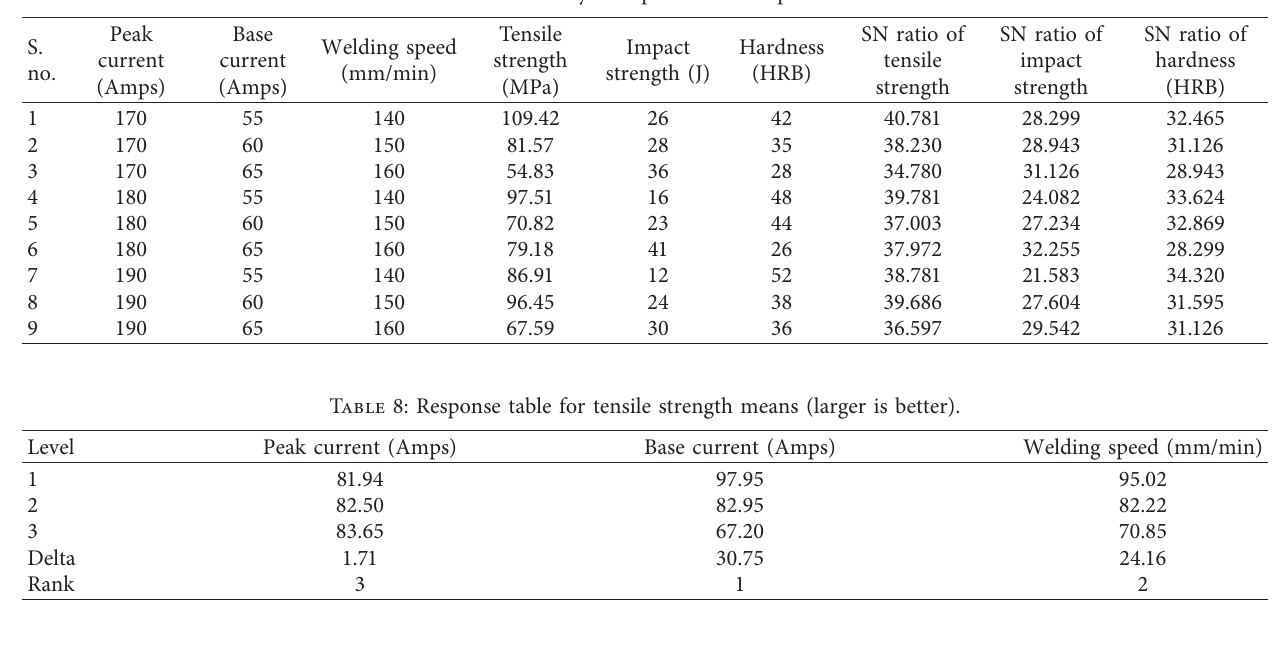
Table 7: Summary of experimental output values.